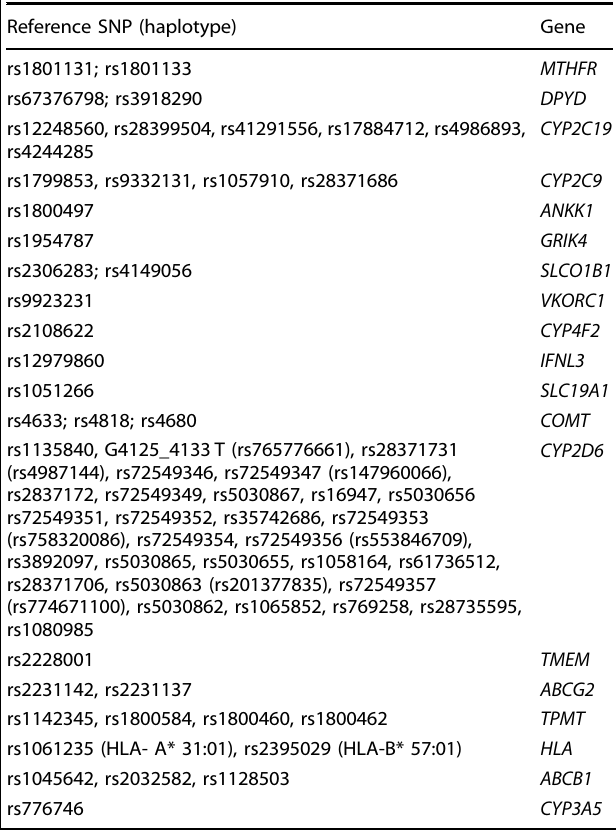
Table 1. Overview of the 67 variants examined and compared Reference SNP (haplotype)